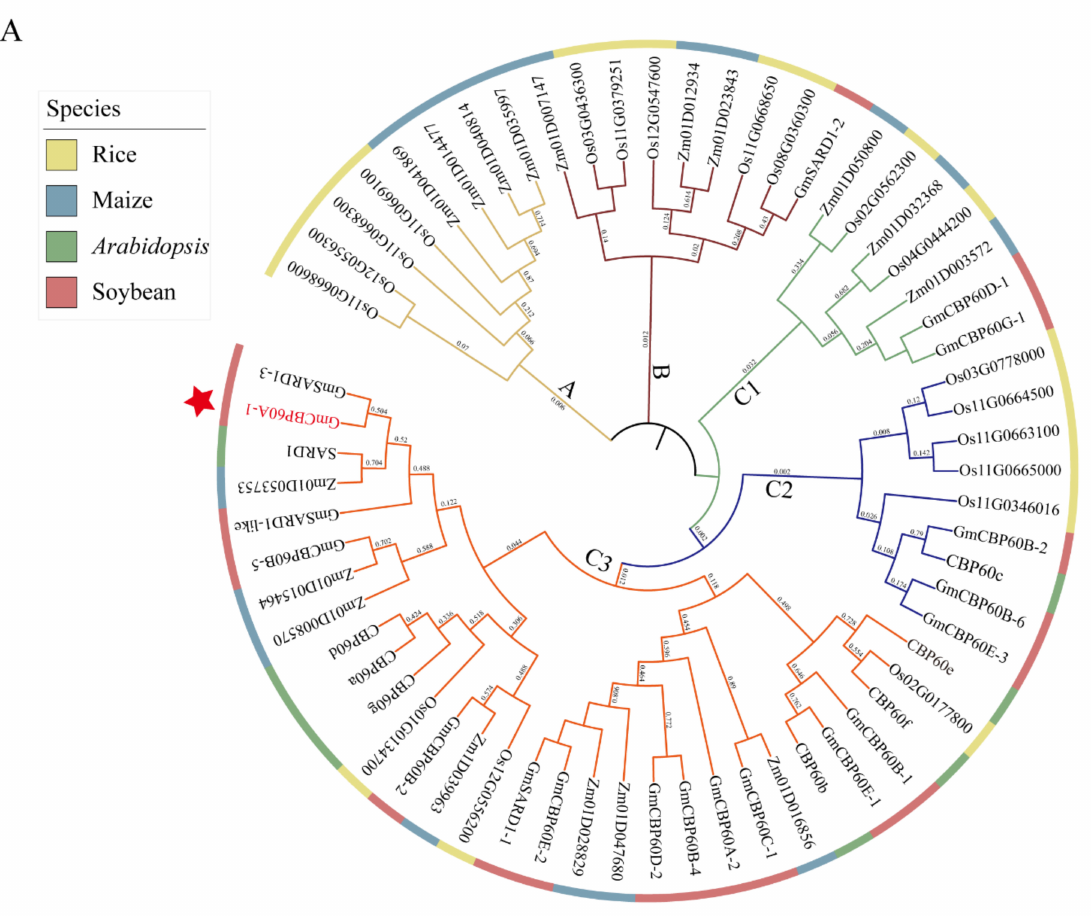
Figure 1. Phylogenetic relationships of CBP60 genes. The unrooted tree was generated with the MEGA-X software using the full-length amino acid sequences of the 63 full-length CBP60 proteins (19, Gm; 19, Os; 17, Zm; 8, At) by the maximum- likelihood (ML) method, with 1000 bootstrap replicates. Different line colors indicate the five major branches. The red star indicates the main study gene in this work. Species acronym used: At, Arabidopsis ; Gm, soybean; Os, rice; and Zm,